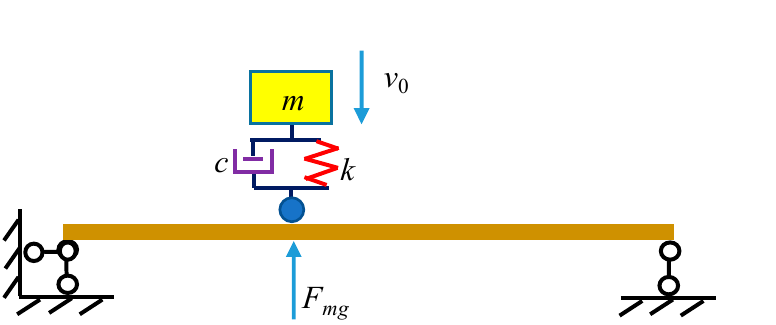
Figure 6. Interface between the vehicle and the bridge in the contact stage.